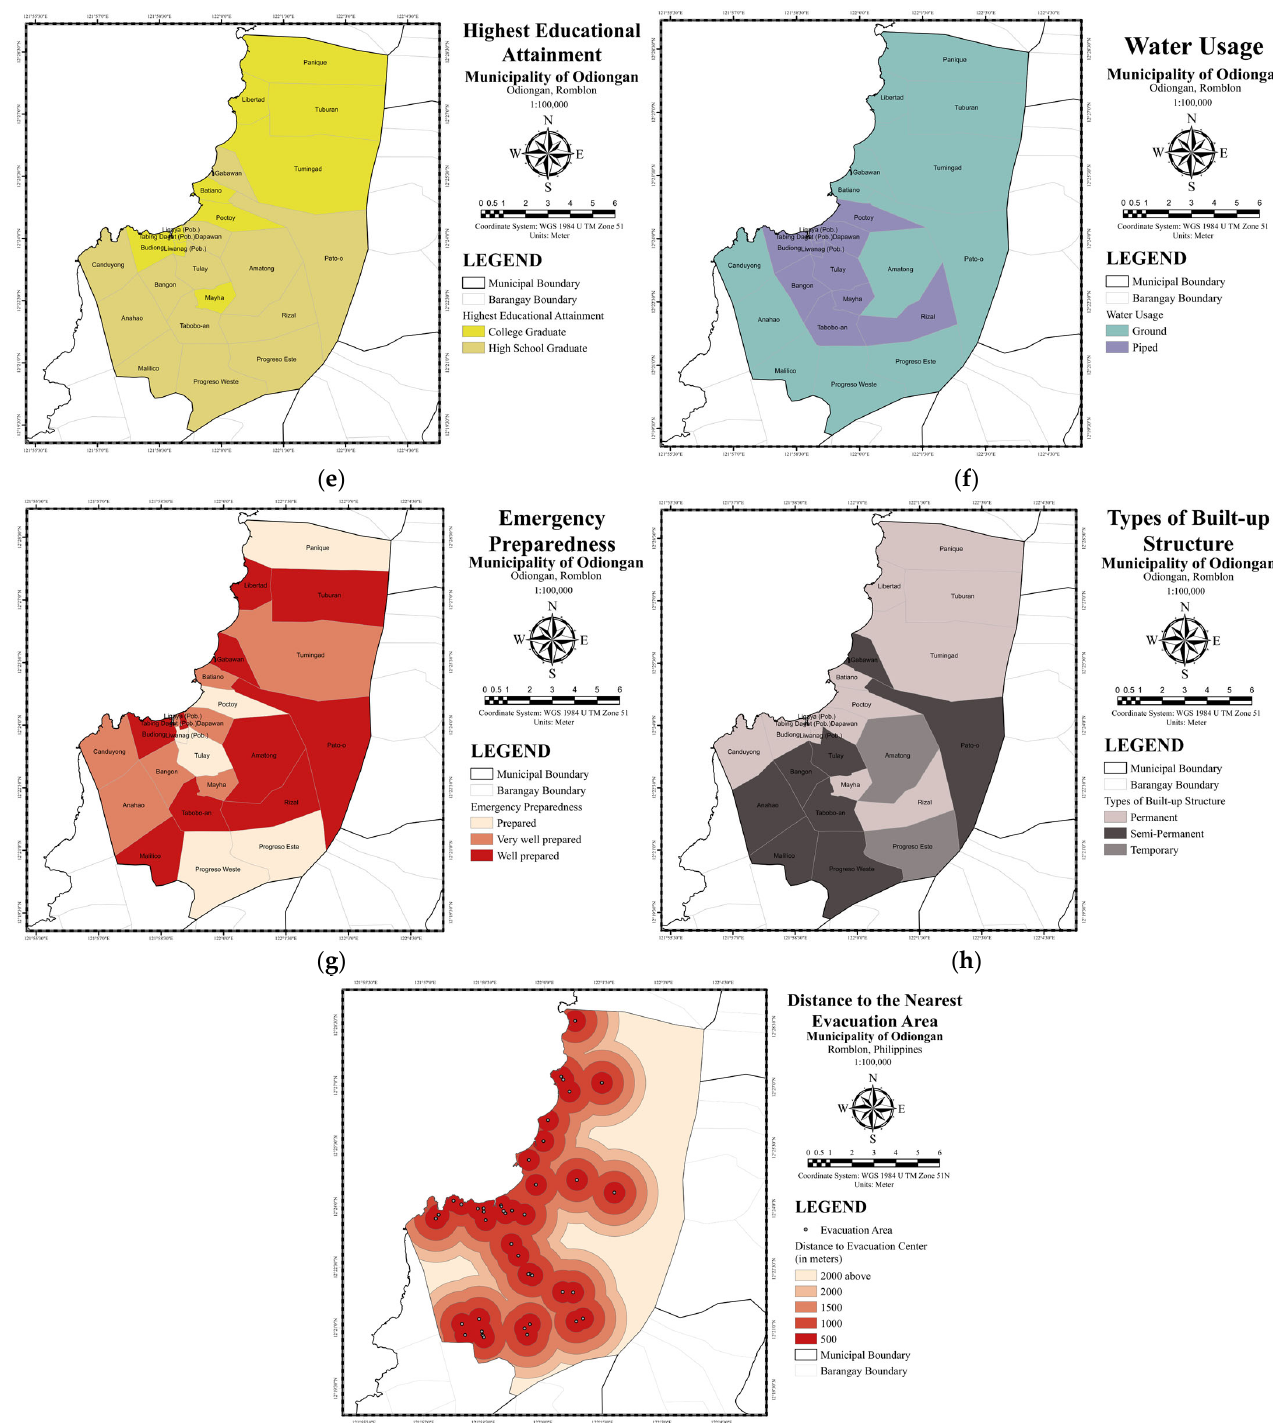
Figure 7. Result maps for flood vulnerability parameters in Odiongan, Romblon using ArcMap: ( a ) Gender Ratio; ( b ) Mean Age; ( c ) Average Annual Income; ( d ) Number of PWD; ( e ) Highest Educational Attainment; ( f ) Water Usage; ( g ) Emergency Preparedness; ( h ) Types of Built ‐ up Structure; and ( i ) Distance to the Nearest Evacuation Center.